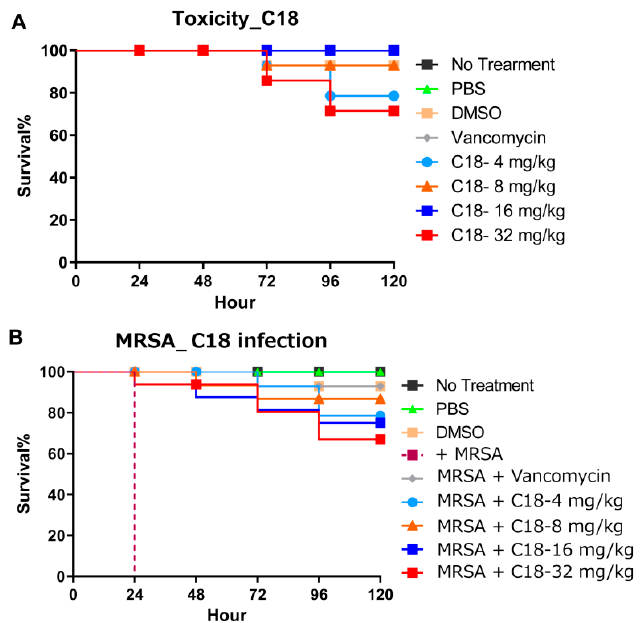
Figure 5. The in vivo activity of the designed peptide in a G. mellonella model. ( A ) The toxicity of the peptide in the whole animal model. More than 70% of larvae survived the toxicity even at 32 mg/kg until 120 h ( p < 0.05). ( B ) The protection of the G. mellonella larvae by the peptide and the antibiotic post-MRSA infection. Similar concentrations of the agents were used to compare the toxicity with the actual protection effects. Larvae treated at 4 mg/kg showed more than 80% sur- vival at 120 h post-infection ( p < 0.05).